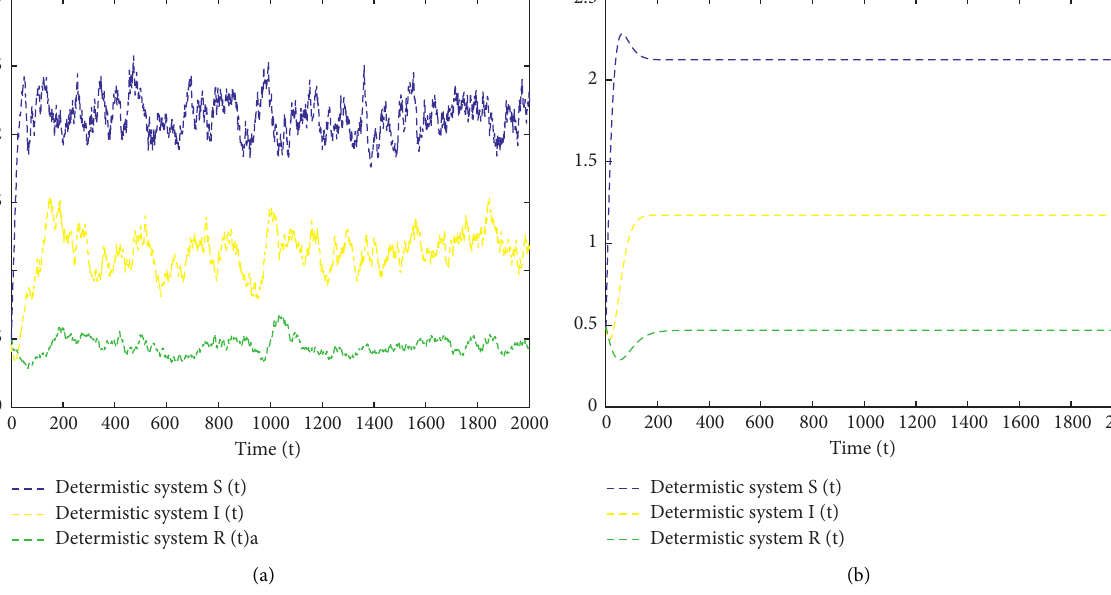
> 1 and deterministic system 0